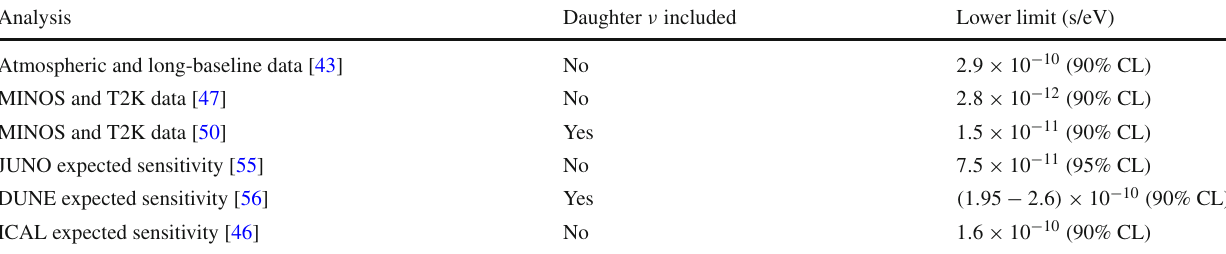
Table1 Currentandprospectiveconstraints(expectedsensitivities)onneutrinolifetimefromneutrinooscillationexperiments.Thelowest(highest) value for DUNE sensitivity is for the highest (lowest) m 1 lightest neutrino mass. All results assume the